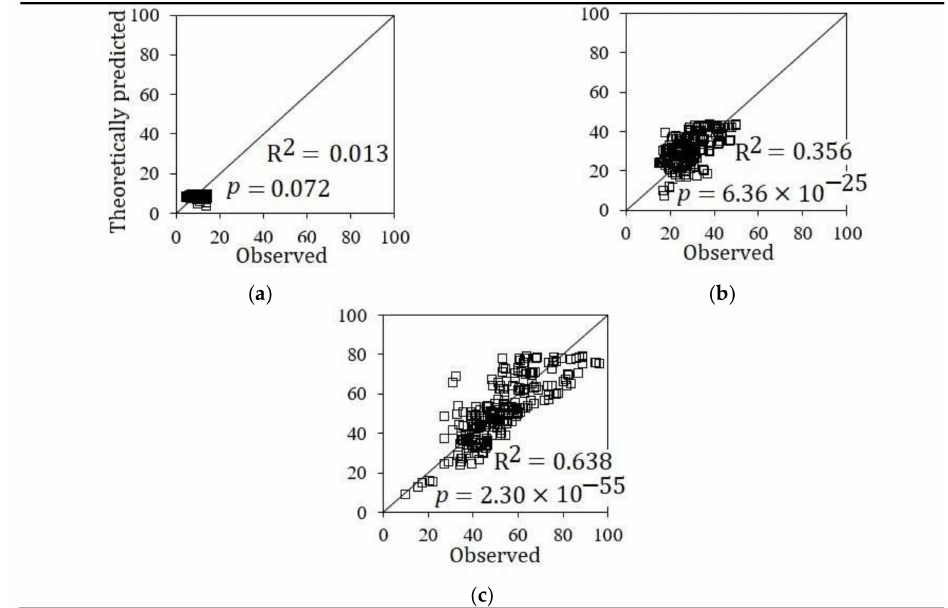
Figure 16. Relationship between observed and theoretical RGB values of the model fitting in image analyses (n = 245). ( a ) R values, ( b ) G values and ( c ) B